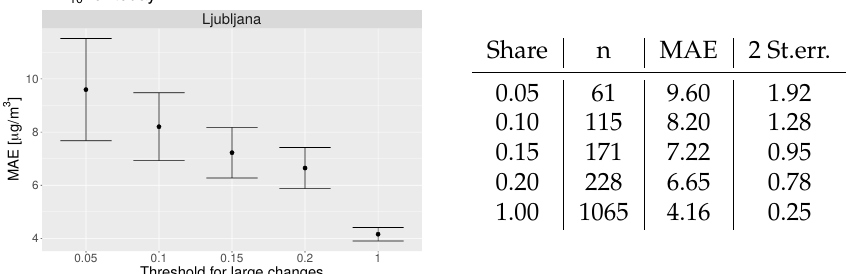
Figure 5. Model performance on the entire dataset (figure left x -axis 1) and on different shares of highest ∆ C( ∆ t). The figure on the left shows MAE with two standard errors for the example discussed above (see Figures 3 and 4). There is a significant increase in MAE for the largest ∆ C( ∆ t) compared to MAE for all instances. We can also display the numerical results in a table (see left; Share—the share of ∆ C( ∆ t) labeled as large, n—number of instances, MAE—mean absolute errors, 2 St. err—two standard errors).